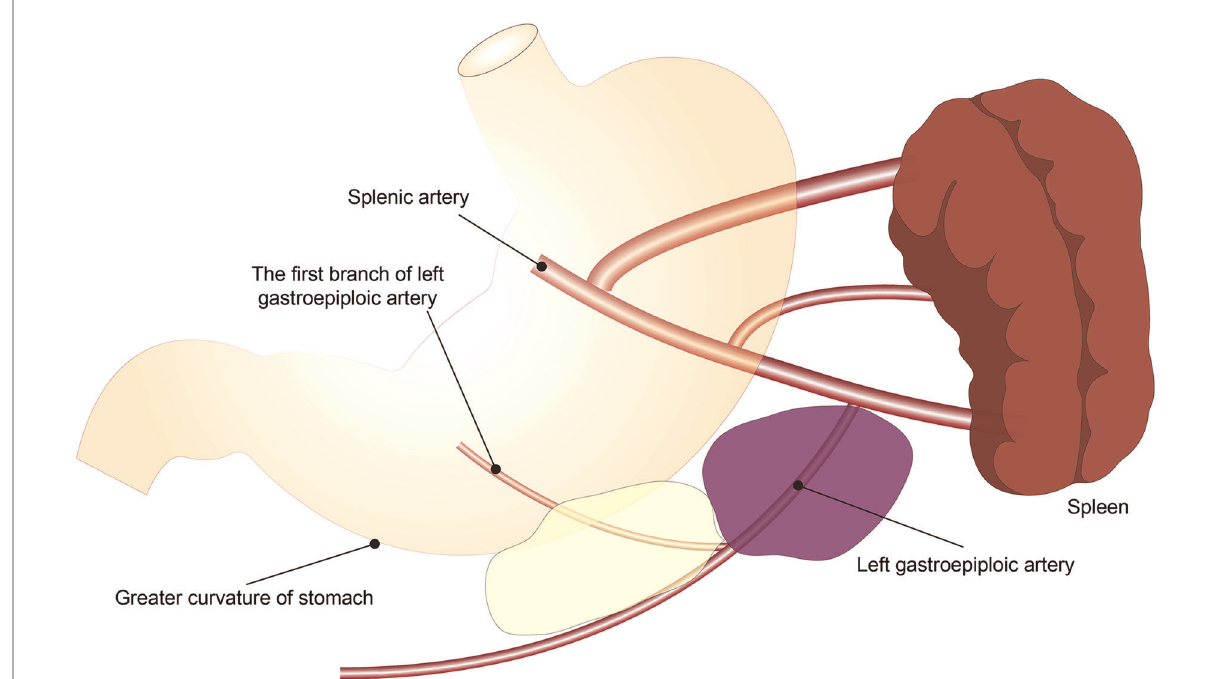
FIGURE 3 Schematic diagram of the scope of 4sb lymph node dissection. The yellow area is the experimental group, and the yellow plus purple area is the control